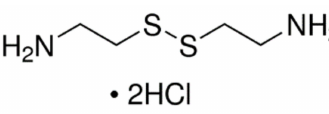
Figure 1. The chemical structure of cystamine